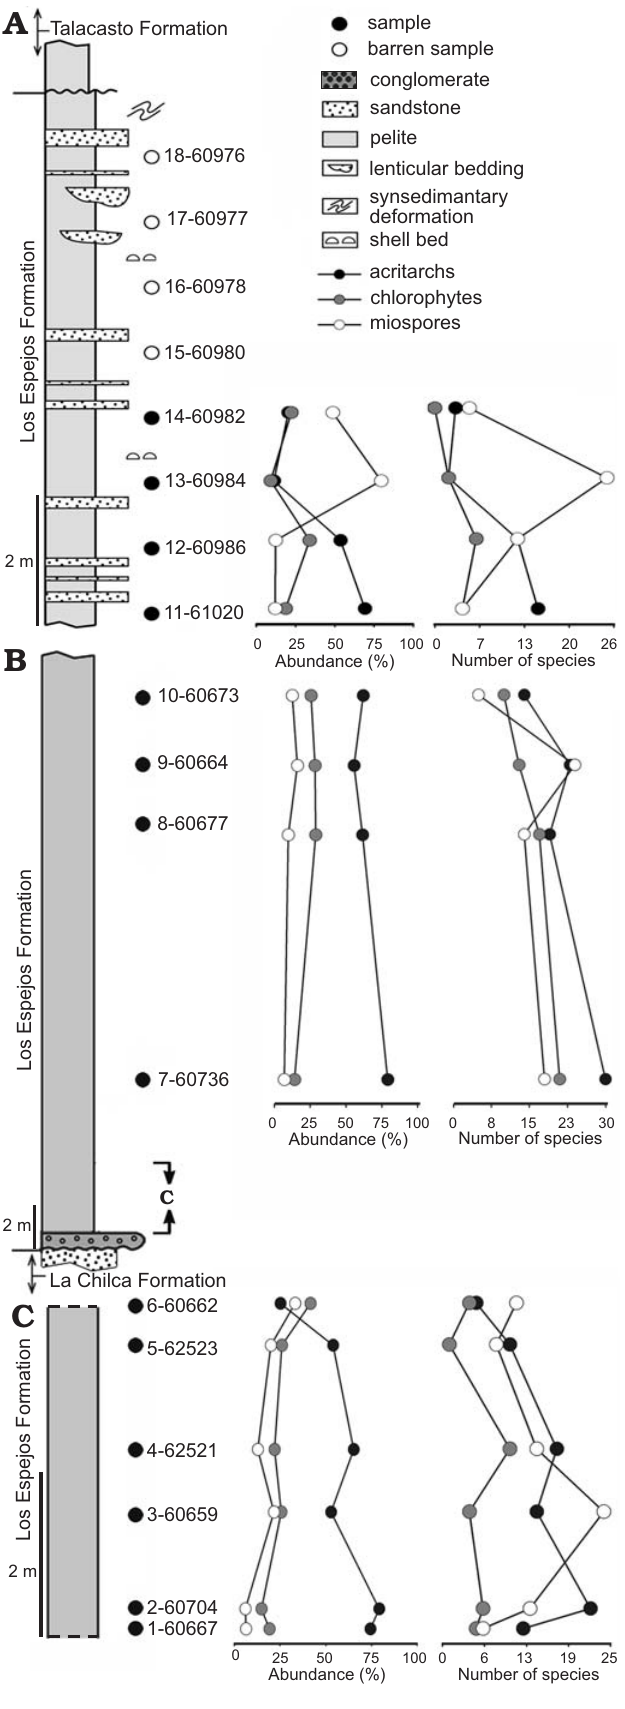
Fig. 3. Stratigraphic section of the Los Espejos Formation in the Que brada Ancha area upper ( A ) and lower ( B , C ) parts, showing relative abundance (in %) and diversity (number of species) of acritarchs, chlorophytes, and miospores per